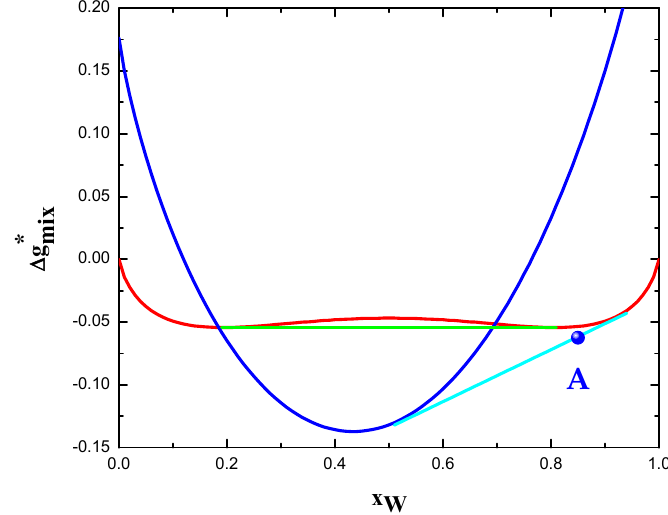
Figure 4. Phase equilibria of the system W-Cr at 1673.15 K. Dimensionless Gibbs free energy as function of composition is reported for bulk solid solution (red), phase separated state (green), as well as grain boundary phase (blue). Polycrystalline stable states are given by the common tangent (cyan) between grain boundary phase and bulk solid solution. Point A represents the most stable state of the experimentally investigated W-15 at.% alloy.